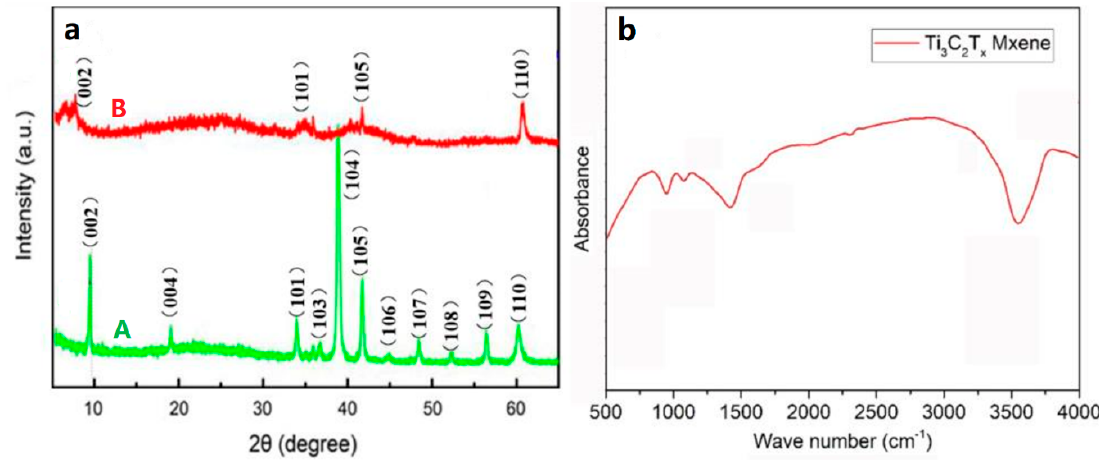
Figure 4. ( a ) XRD patterns of Ti 3 AlC 2 MAX (A) and Ti 3 C 2 T x nanosheets (B). ( b ) FTIR spectra of Ti 3 C 2 T x nanosheets.